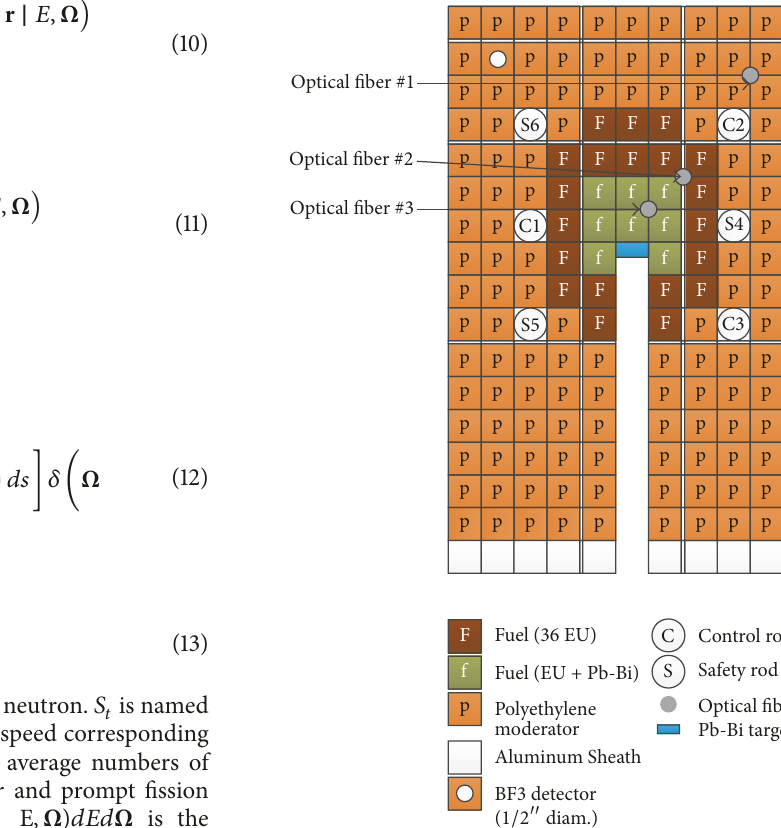
Figure 1: Core configuration of the PNS experiment (Case